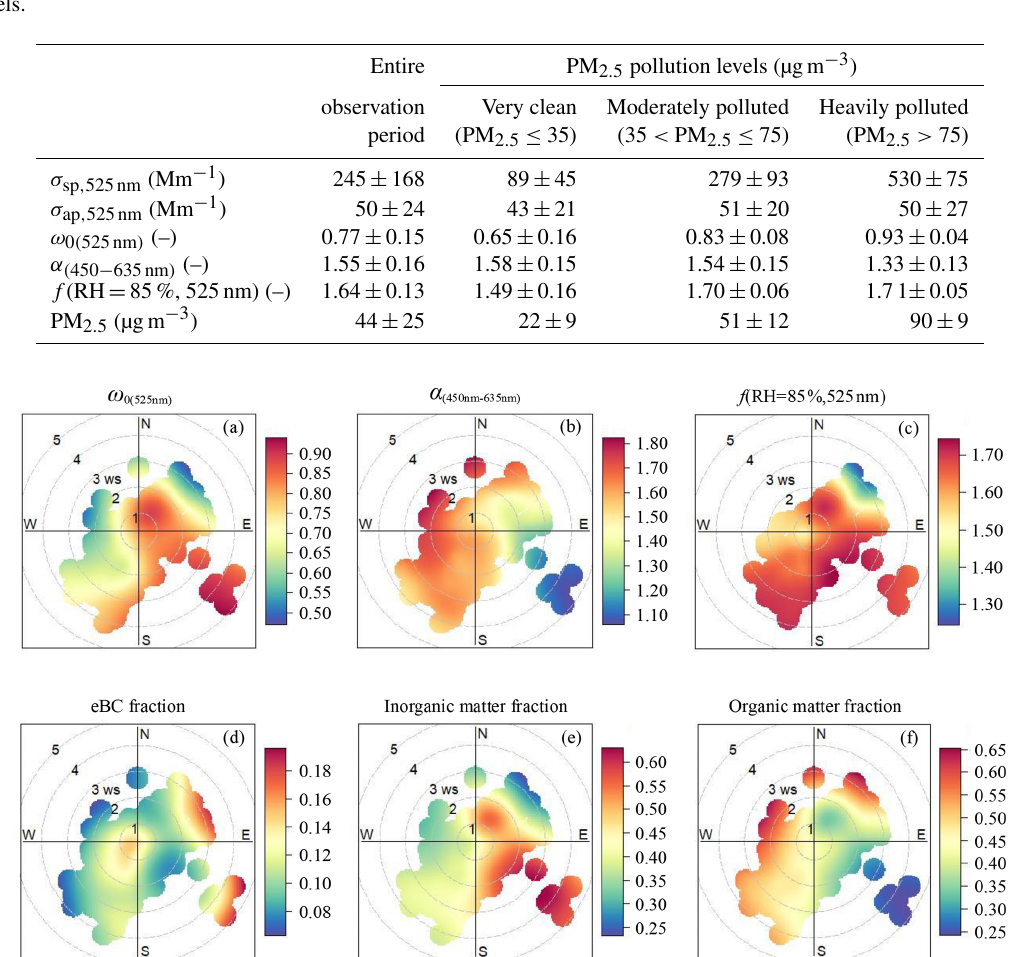
Figure 2. Wind dependence of (a) the single-scattering albedo ( ω 0 ( 525nm ) ), (b) the scattering Ångström exponent ( α ( 450 − 635mm ) ), (c) the particle light scattering enhancement factor at RH = 85% ( f (RH = 85%, 525nm)), (d) the mass fraction of eBC, (e) the mass fraction of inorganic matter, and (f) the mass fraction of organic matter. The circular contours show the average change in wind speed and